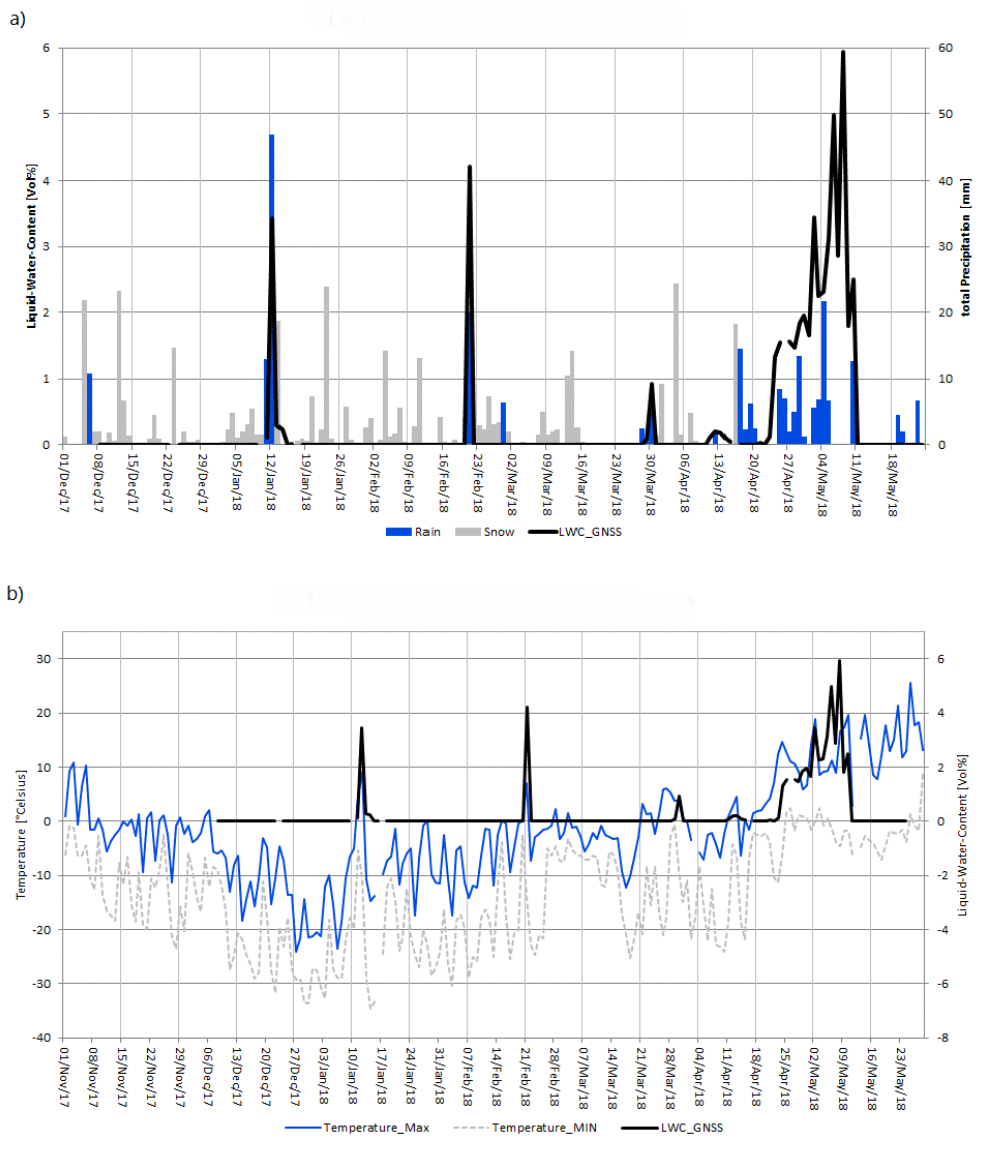
Figure 6. Daily GNSS-derived LWC values at the Forêt Montmorency NEIGE site for the winter season 2017/2018 related to ( a ) rain and snowfall events and ( b ) air temperature development. Temperature and precipitation measurements were conducted at the close-by provincial and federal station